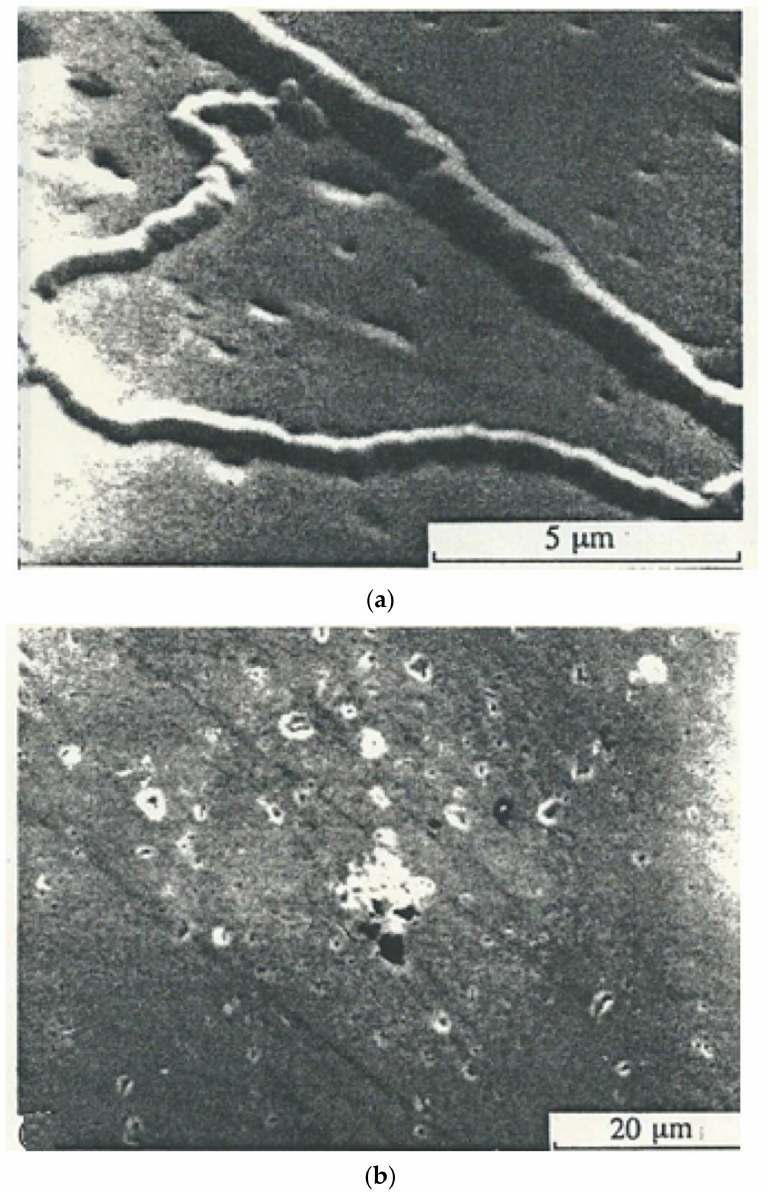
Figure 13. Scanning Electron Microscopy images of the iron surface after atmospheric corrosion test during 10 ks at 100% RH with 10 monolayers ( a ) and 18 monolayers ( b ) of BTMS [21]. Published with permission from NAUKA/INTERPERIODIKA